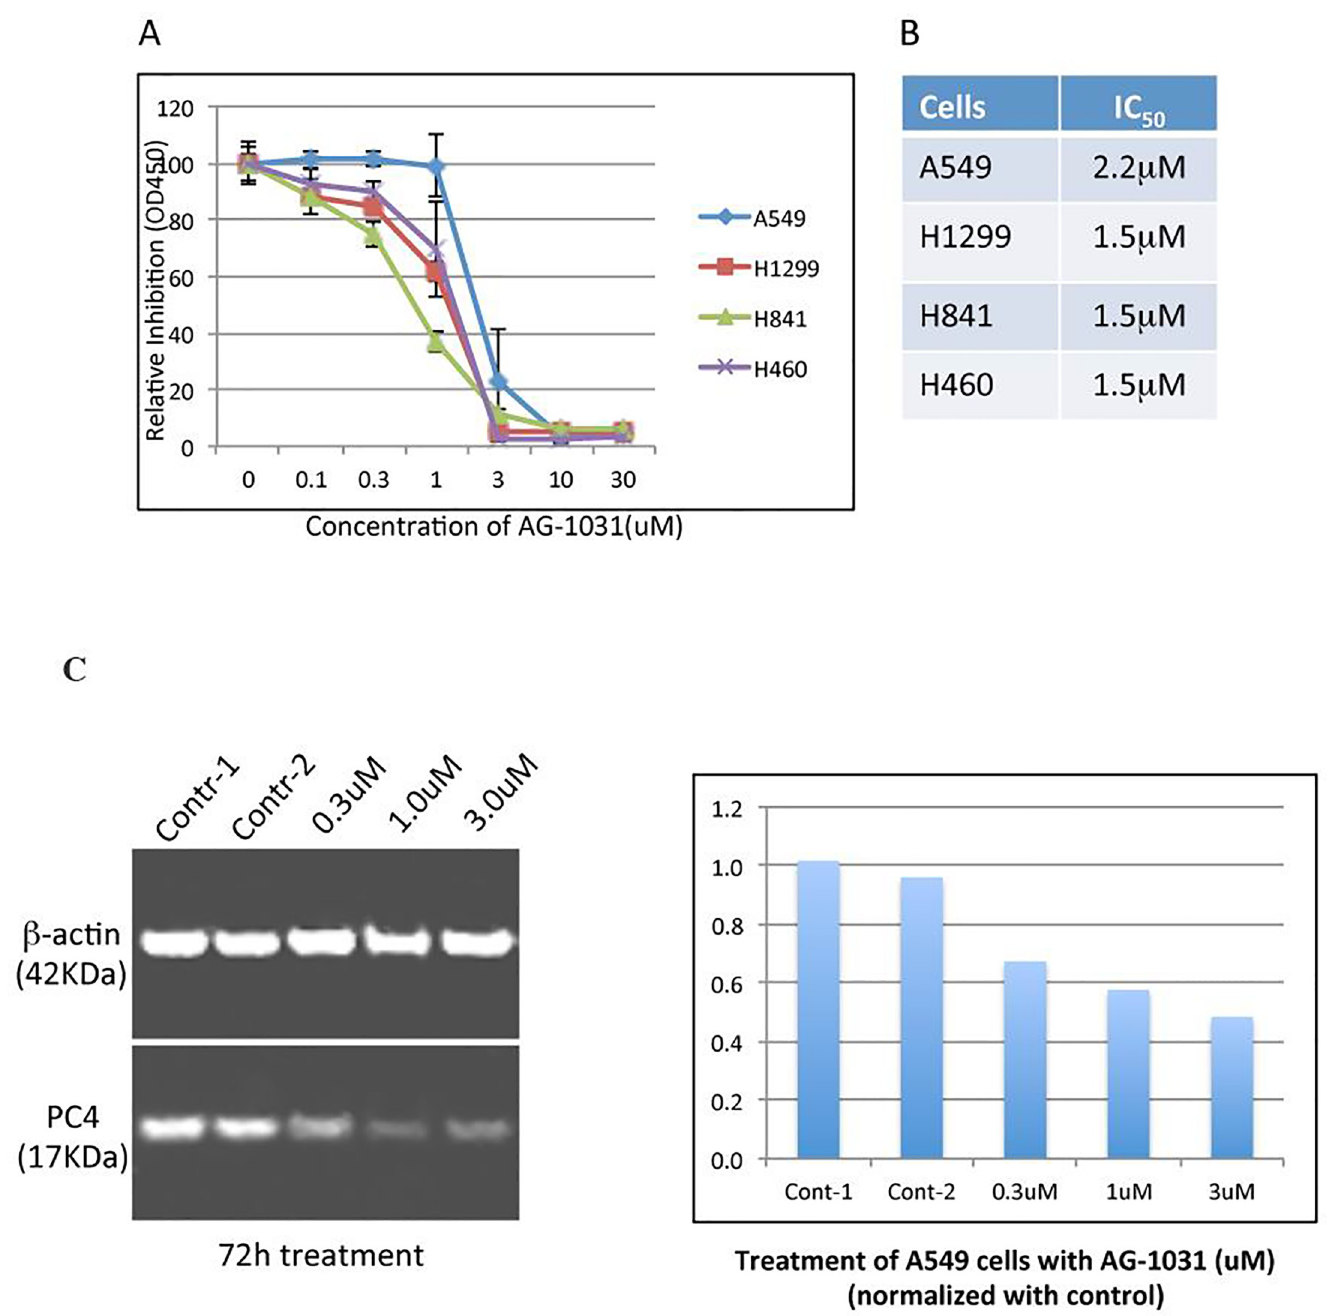
Fig 3. AG-1031 inhibits the viability of lung adenocarcinoma cell lines. NSCLC cell lines A549, H1299, H841 and H460 were incubated in the presence of increasing concentrations of AG-1031. Viable cells were counted 48 hrs post-treatment by using a cell counting kit and measured using a 96- well plate reader at OD 450nm . AG- 1031 showed inhibitory effect on all of four cell lines with IC50 between 1–2 μ M (Fig 3A and 3B). Western blot analysis showed that treatment of A549 cells with AG- 1031 resulted in down-regulation of PC4 in a concentration-dependent manner (Fig 3C/left panel). Expression of β -actin was used as the control. The density of PC4 expression was semi-quantified and the relative inhibition was plotted (Fig 3C/right panel).